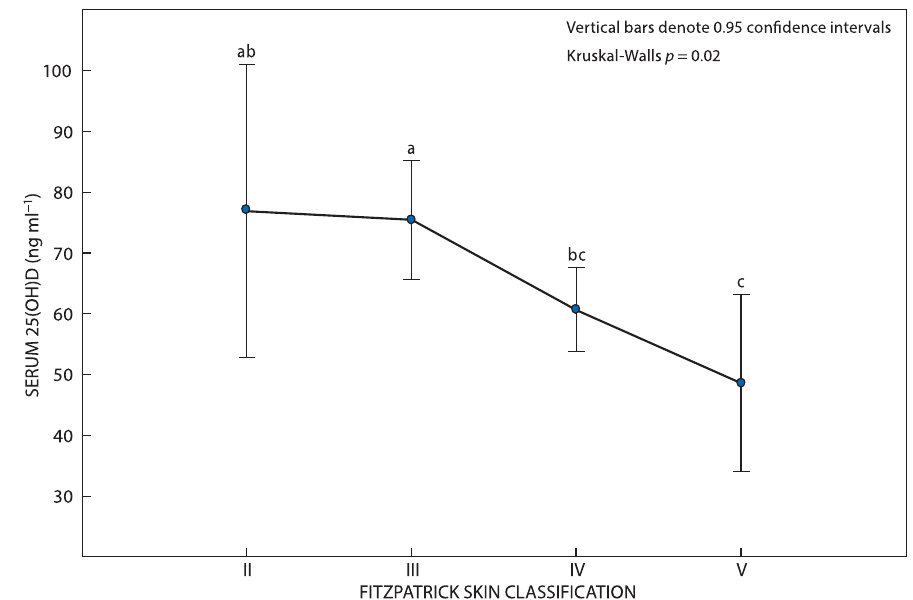
Figure 1: Serum 25(OH)D and Fitzpatrick skin type classi fi cations. Participants with lighter skin tones (II and III) had signi fi cantly higher 25(OH)D levels than those with darker skin tones (IV and V) ( p = 0.02).